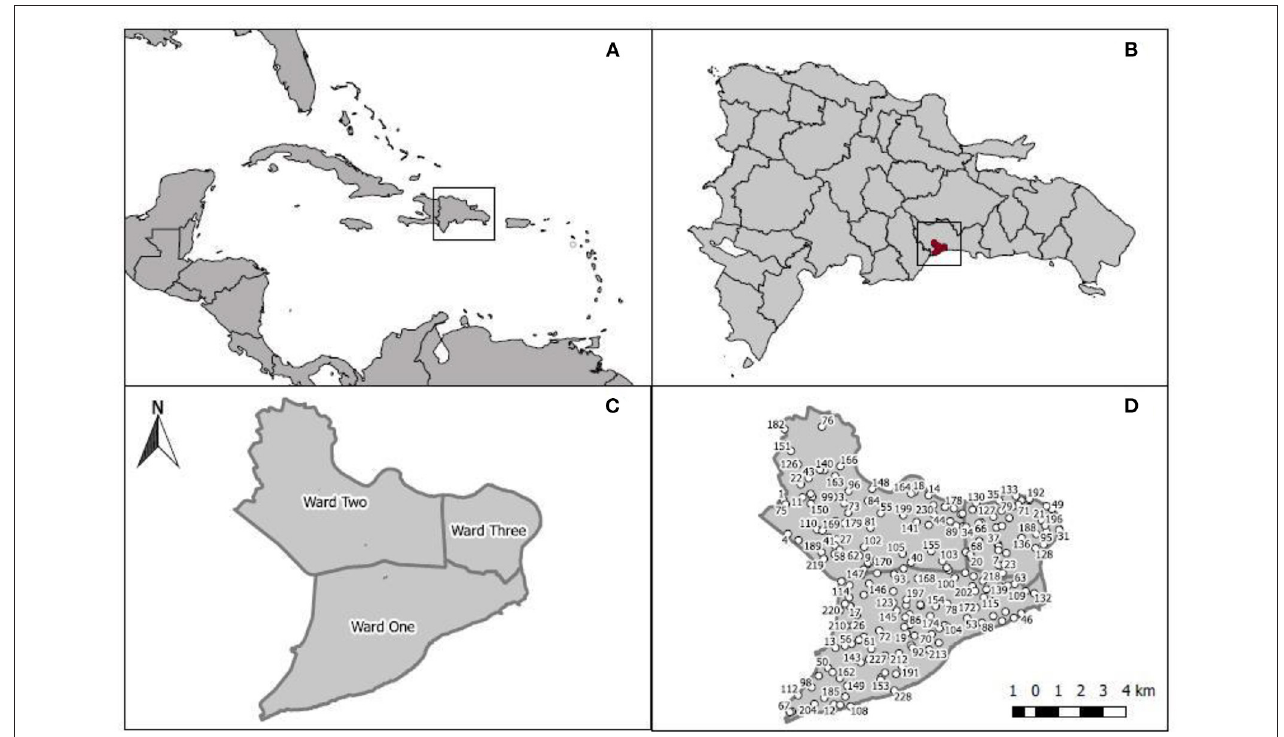
FIGURE 1 | Study area. (A) Hispaniola, (B) Dominican Republic and Santo Domingo, National District and its three wards, (C) and the 206 randomly distributed circular plots (D)